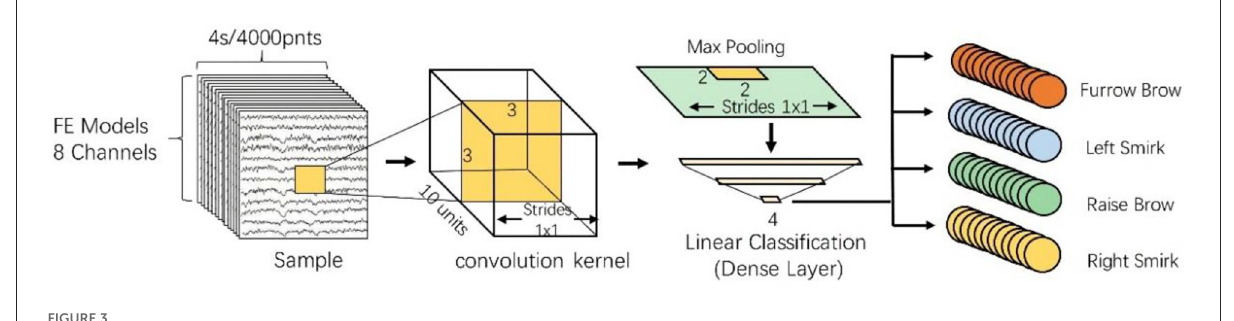
FIGURE3 Architecture of the proposed CNN